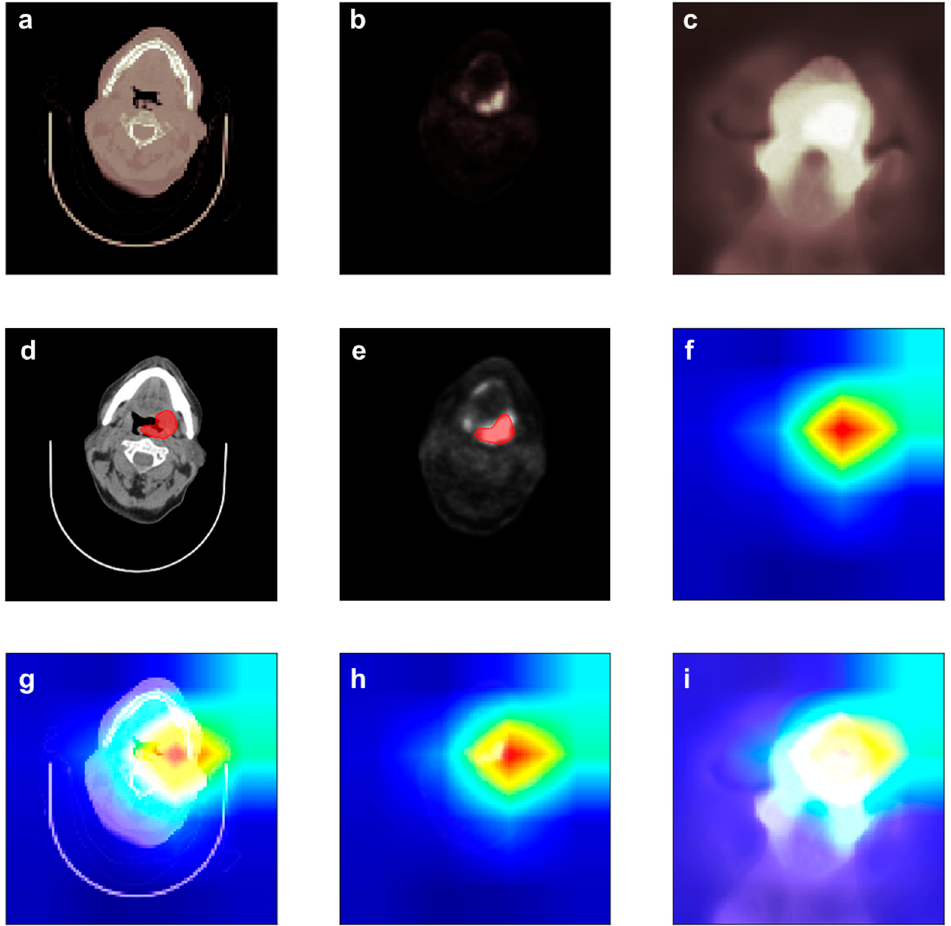
Figure 4. Heat map of LR positive patient produced by the CPD-C model: ( a ) Input images of CT. ( b ). Input images of PET. ( c ). Input images of dose distribution. ( d ). Contour images of CT. ( e ). Con- tour images of PET. ( f ). The heatmap. The red region in the heatmap indicates where the important region to make decision of LR. ( g – i ) are superimposed images of CT, PET, and dose distribution and heatmap, respectively.